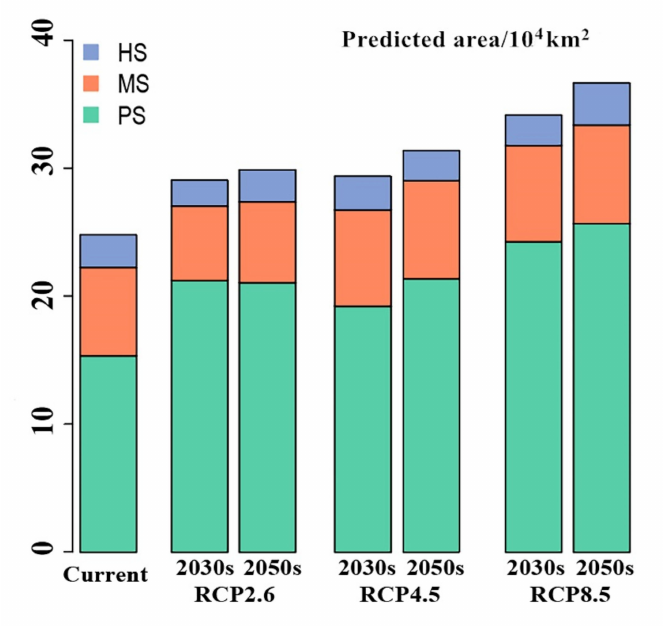
Figure 6. Predicted suitable areas for T. klimeschi under current and future climatic conditions (PS represents poorly suitable; MS represents moderately suitable; HS represents highly